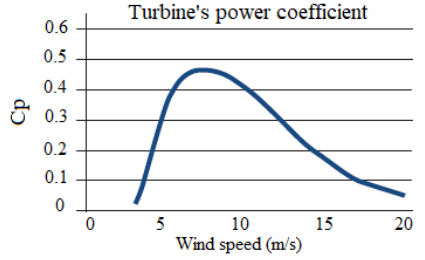
Figure 6. Vestas V82-1.65 turbine power curve. Courtesy Vestas Wind System.